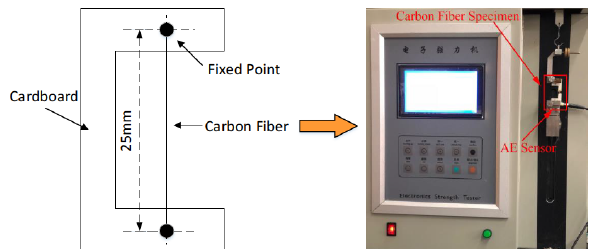
Figure 1: Single fiber tensile